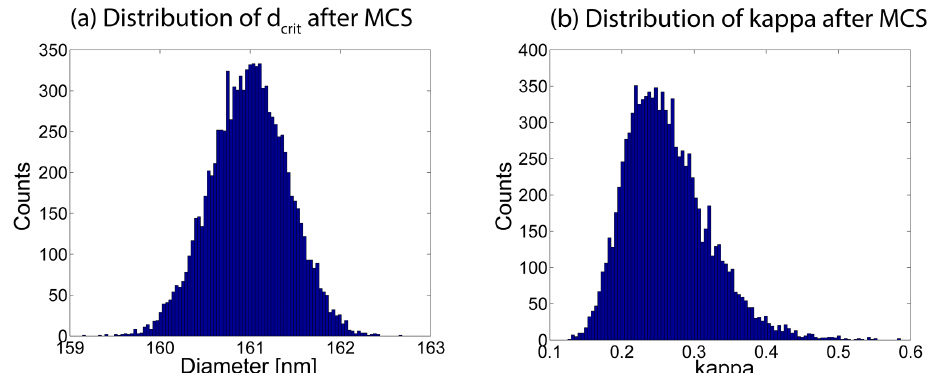
Figure A1. (a) Distribution of 10000 d crit values after applying the MCS. The mean and the standard deviation of this distribution are the final d crit and its uncertainty due to the 5% uncertainty in the particle number concentration of each size bin in the PNSD, respectively. (b) Distribution of 10000 κ values after applying the MCS. As this results in a log-normal distribution of κ values it is more appropriate to use the median and percentiles as the final κ value and its uncertainty,